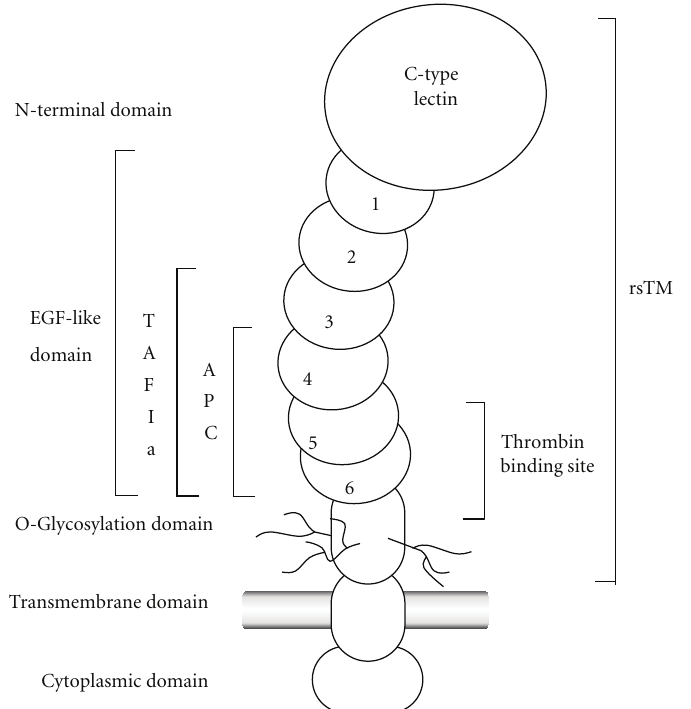
Figure 3: Structure and domains of TM. TM contains an N-terminal C-type lectin-like domain, an extended stalk of six EGF modules, a serine/threonine-rich region with target sites for posttranslational glycosylation, a transmembrane domain, and a short cytoplasmic domain. EGF domains 5-6 bind thrombin. EGF4-6 is required for protein C activation and EGF3-6 for TAFI